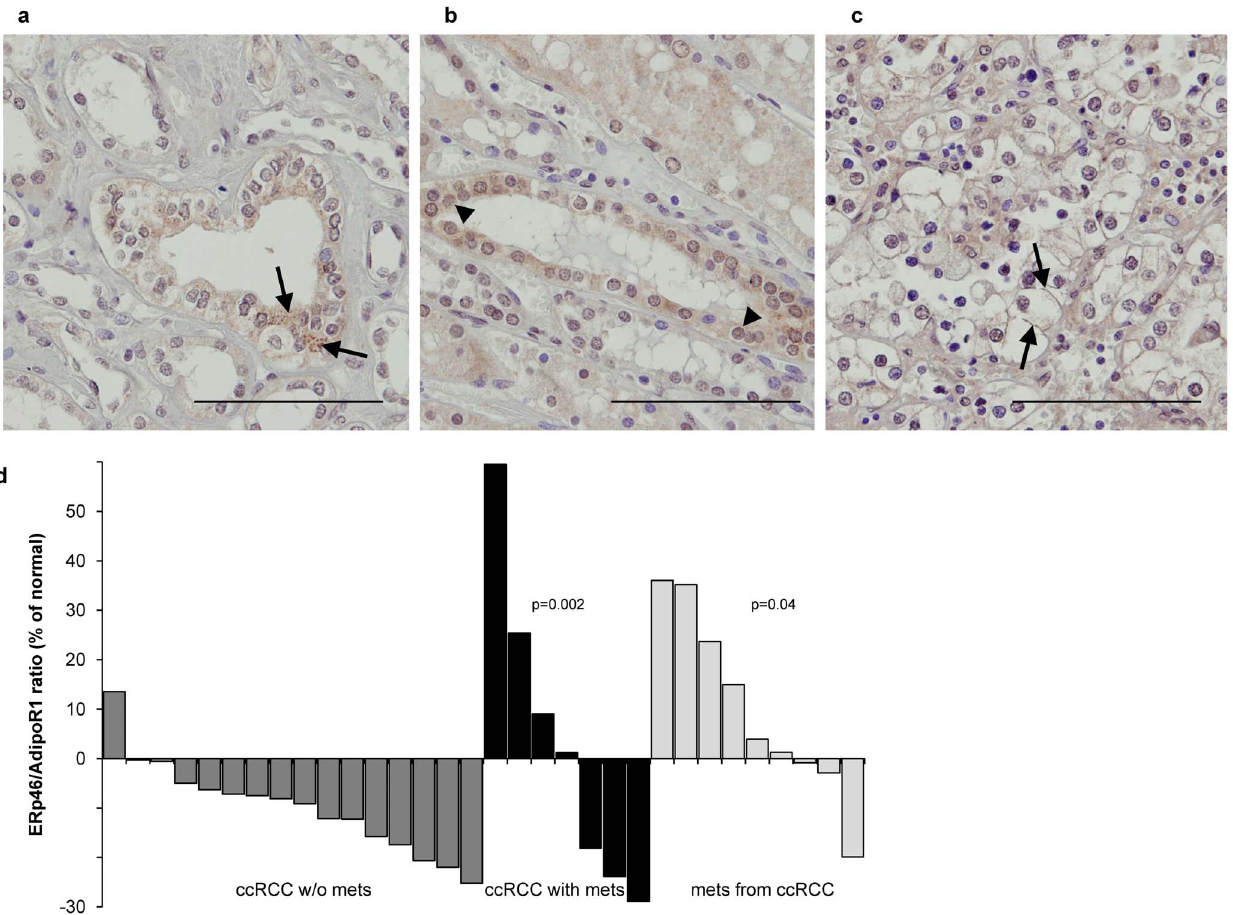
Figure 1. ERp46 expression is increased in metastatic human ccRCC tissue. ERp46-immunohistochemistry of human normal kidney tissue demonstrates ( a ) granular cytoplasmic staining typical for ER (examples indicated by the arrows), but also ( b ) nuclear staining (arrow heads). ( c ) ERp46-staining of human ccRCC showing plasma membrane staining (arrows). Original magnification 630x; Bar=100 m m. ( d ) The ratio of ERp46/ AdipoR1 protein expression in specimens of ccRCC patients was significantly increased in primary ccRCC from patients with metastasis (p=0.002) and in metastatic tissue (p=0.04). ERp46 and AdipoR1 protein expression was quantified by image analysis (H-score). The AdipoR1 and ERp46 protein expression in the cancer was normalized to their expression in normal tissue. The ratios obtained from the patients with primary ccRCC without distant metastasis are represented by the dark grey bars, the black ones represent the primary ccRCC samples from patients with metastasis, the light grey ones are from ccRCC metastatic